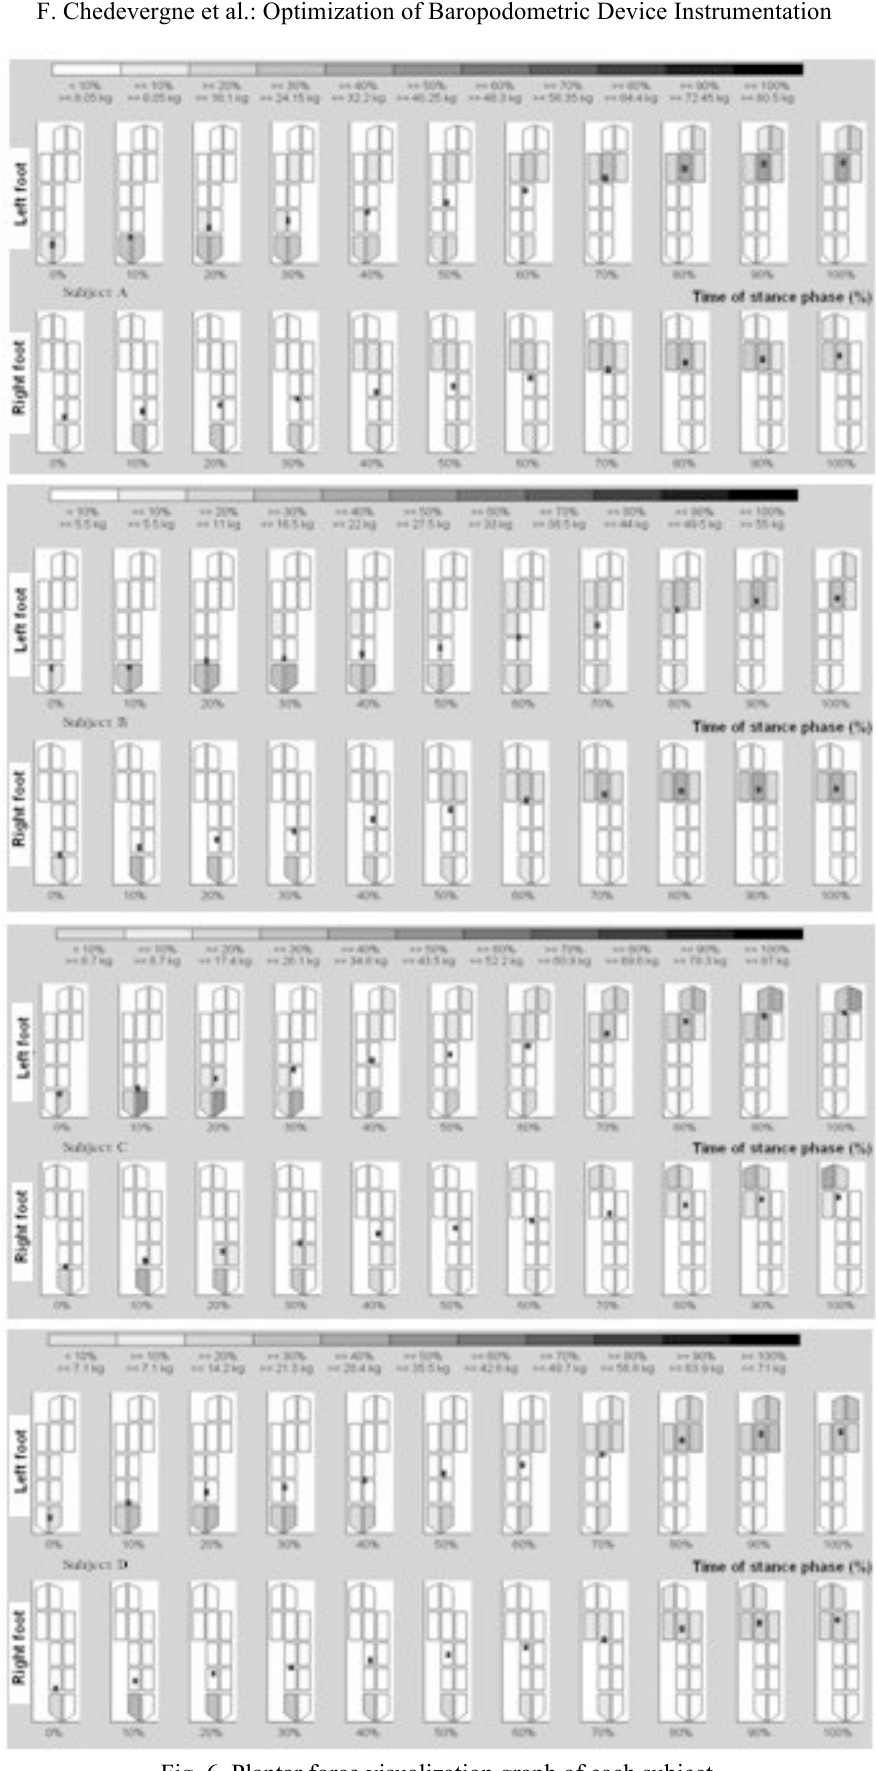
Fig. 6. Plantar force visualization graph of each subject. Mean stance phase over the three trials of a 10-meters back walking